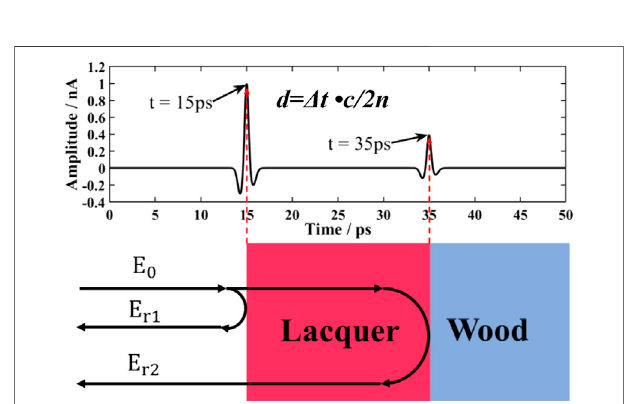
FIGURE 3 | Principle of THz-TDSRI system.